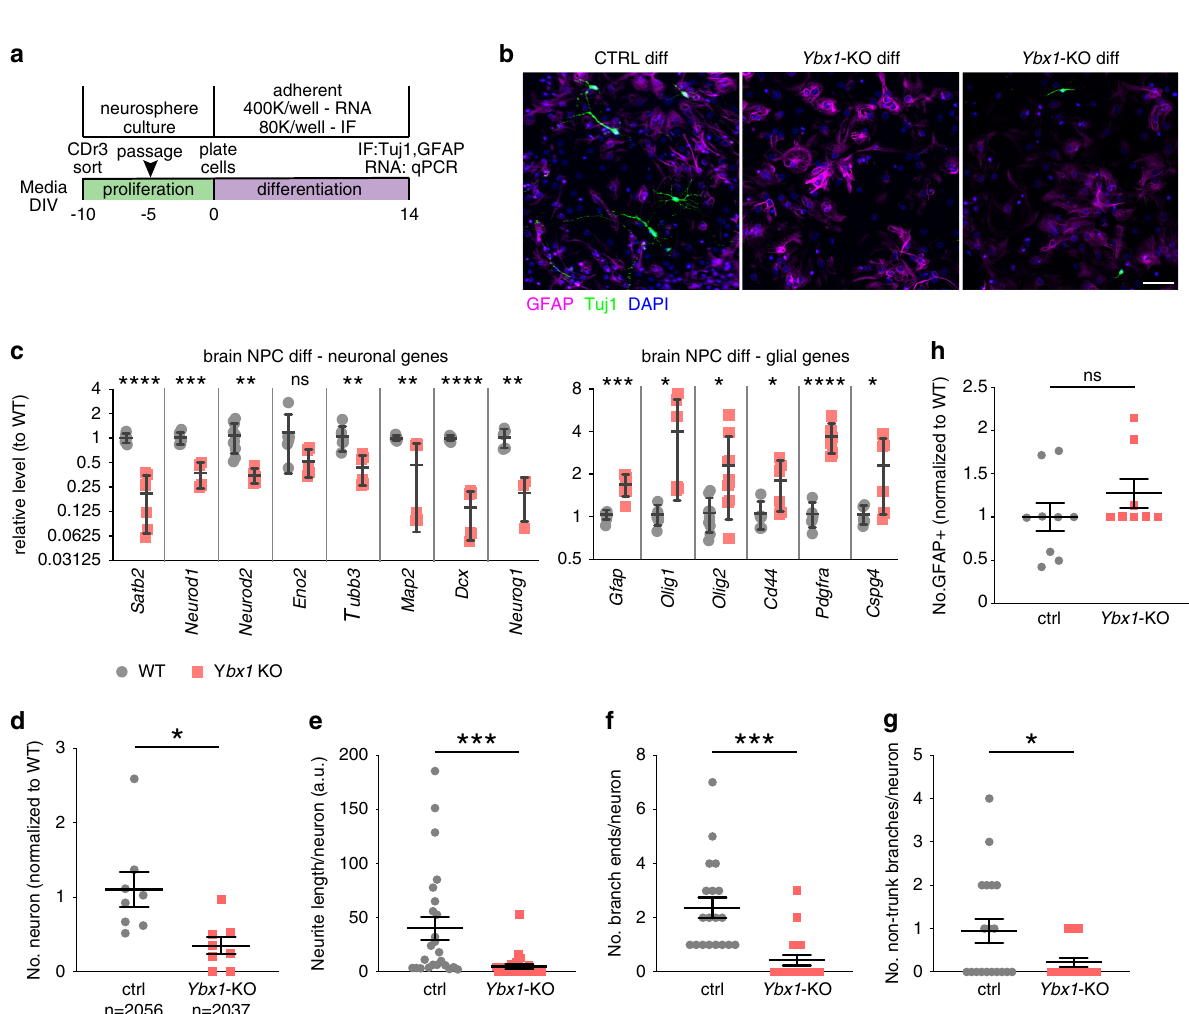
Ybx1 suppresses H3K27me3 levels in brain NPCs . Given that we detected an interaction between Ybx1 and PRC2, we investi- gated whether Ybx1 affects the genomic distribution of H3K27me3, which is deposited by PRC2, and H3K4me3 by low-